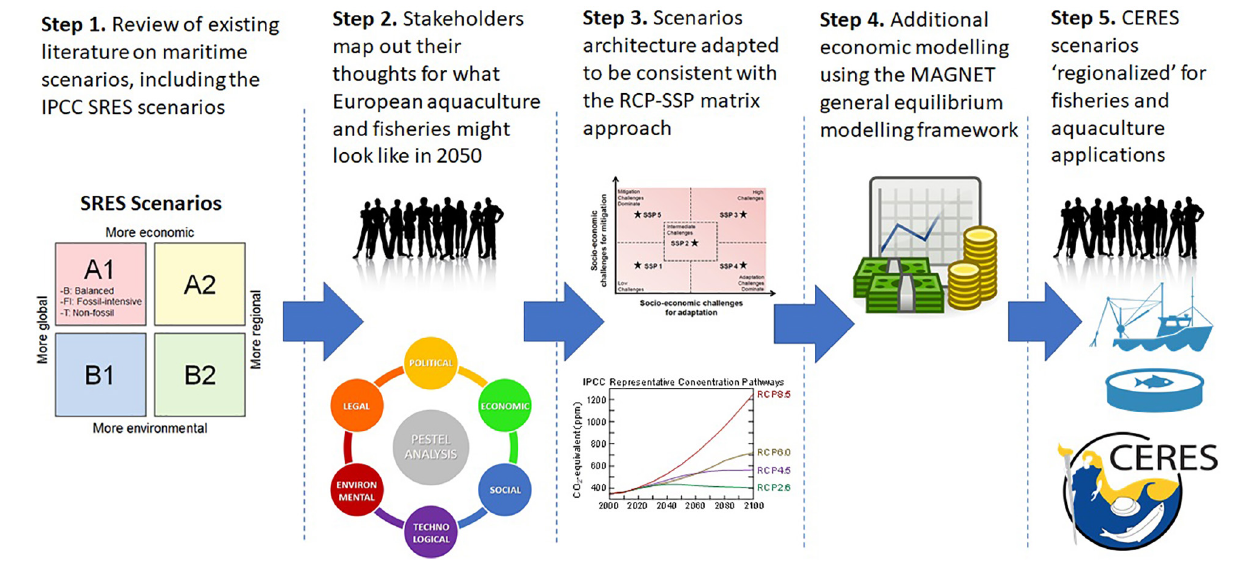
FIGURE 1 | Five-step process through which the CERES scenarios for fisheries and aquaculture were developed.